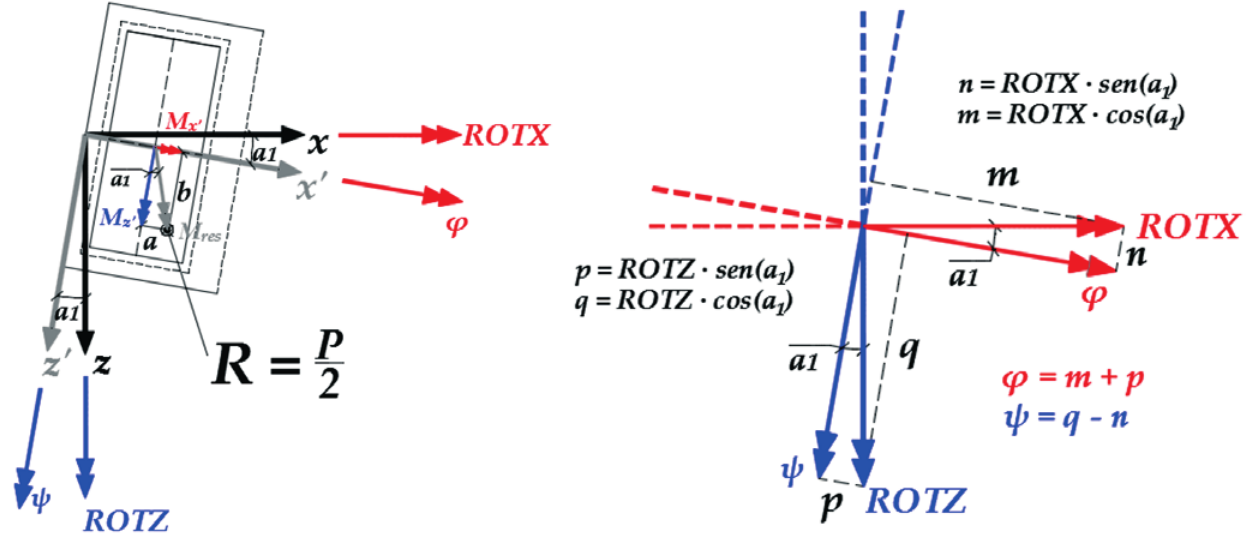
Figura 15 Rotações nos eixos x’ e